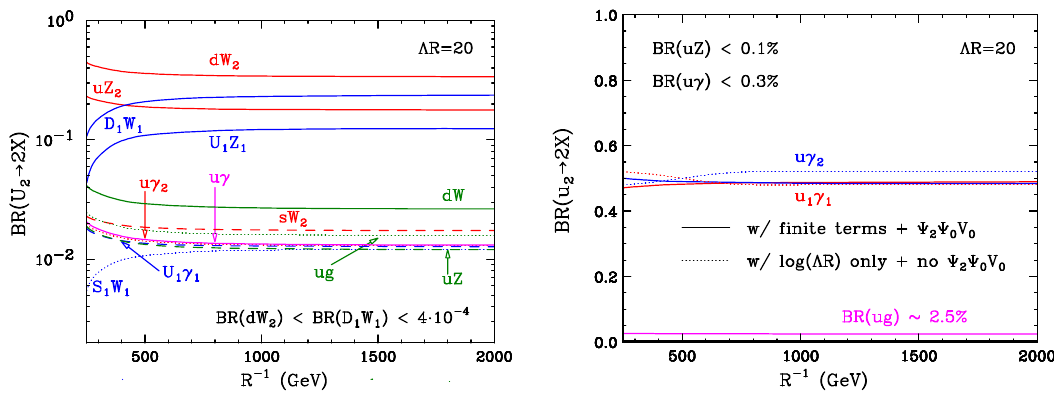
Figure 11 . Branching fractions of SU(2) L -doublet level-2 KK lepton (left) and charged SU(2) L - singlet level-2 KK lepton (right). Solid curves include (cid:12)nite corrections and new decay channels, while dotted curves are old results.